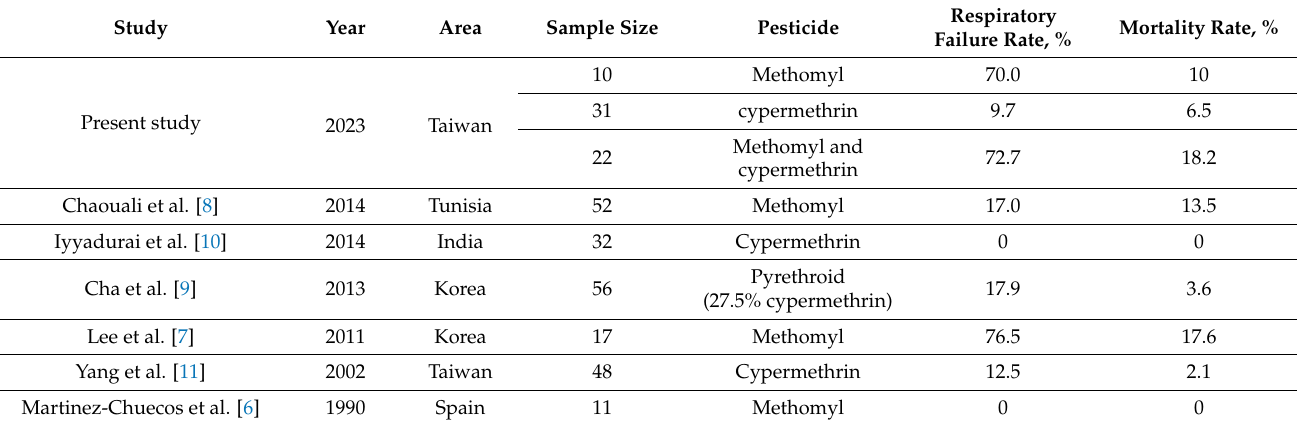
Table 6. Published original studies of human poisoning with methomyl and cypermethrin